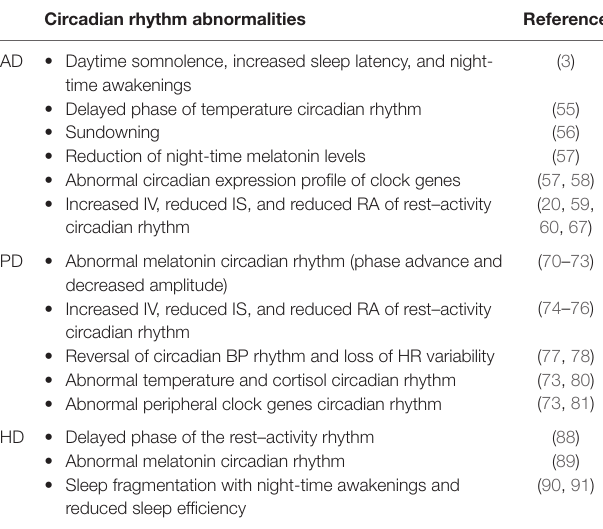
TABLe 1 | Summary of circadian rhythm abnormalities in AD, PD, and